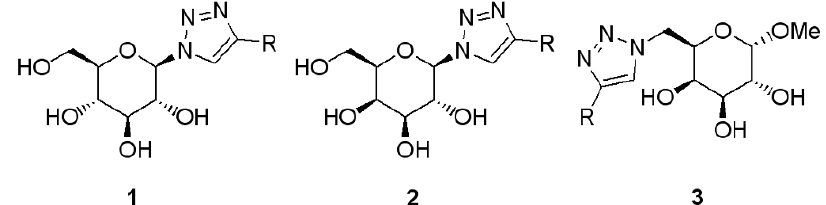
Figure 1. Sugar-triazole conjugates with glycosidases ( 1 ), glycogen phosphorylase ( 1 ) and trans -sialidase ( 2, 3 ) inhibiting activities.